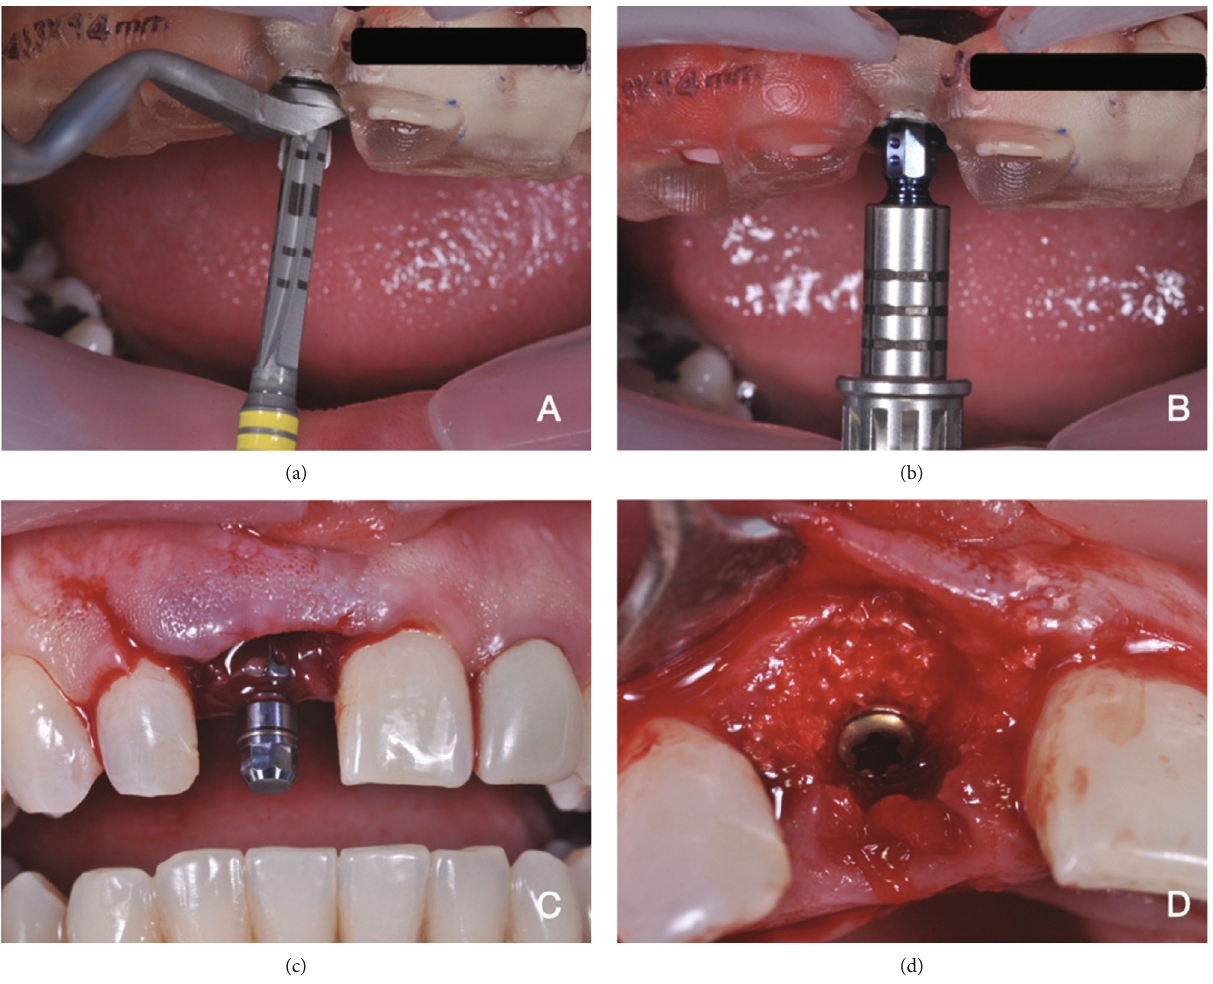
Figure 6: Presentation of the guided implant placement surgery: (a) implant bed preparation; (b) fully guided implant placement; (c) checking the implant for proper fi nal position in relation to the adjacent teeth; (d) guided bone regeneration after implant placement.